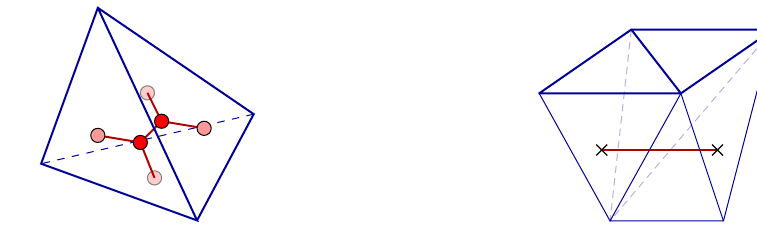
Figure 7: Left: triangulation of the ball S S 2 = D by a single tetrahedron, and dual 3 network. Right: triangulation of the solid torus S T 2 by three tetrahedra. We identify the right face with the left face, and the two faces in the front with the two in the back, while the two upper faces triangulate the boundary T 2 . The dual network has been drawn only after simplification, and it wraps the non-contractible